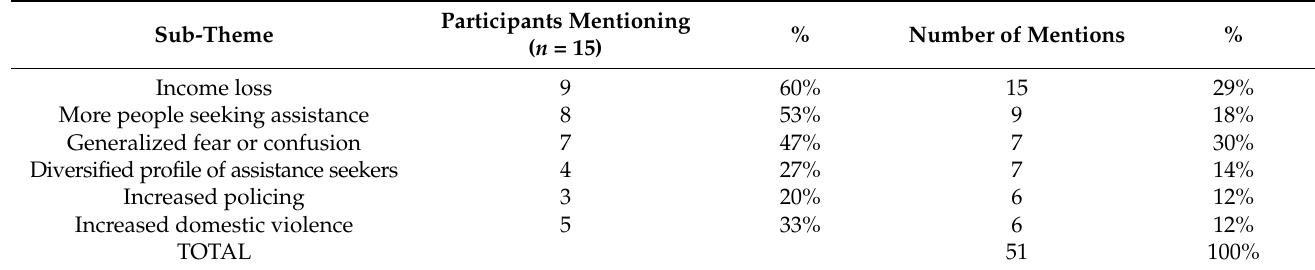
Table 2. Indirect effects of the COVID-19 pandemic on assisted populations according to